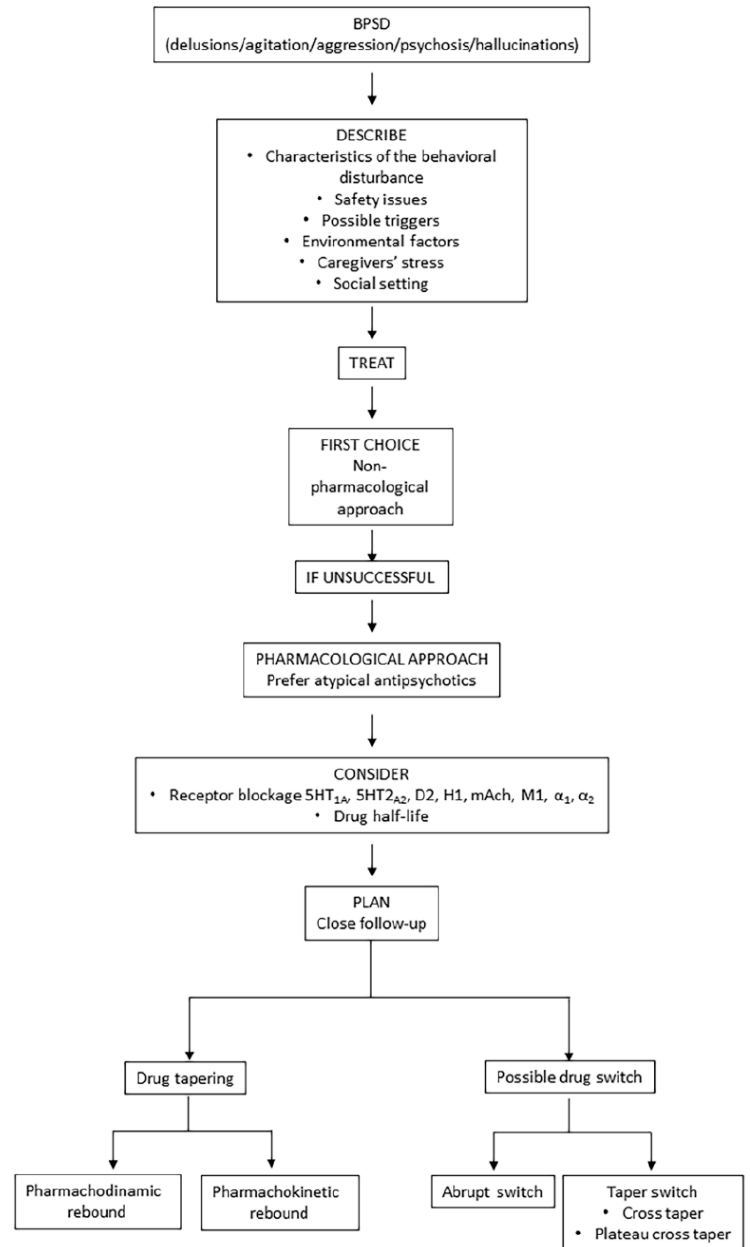
Figure 2. Flow chart for approaching patients with BPSD (in particular delusions/agitation/aggre- ssion/psychosis,